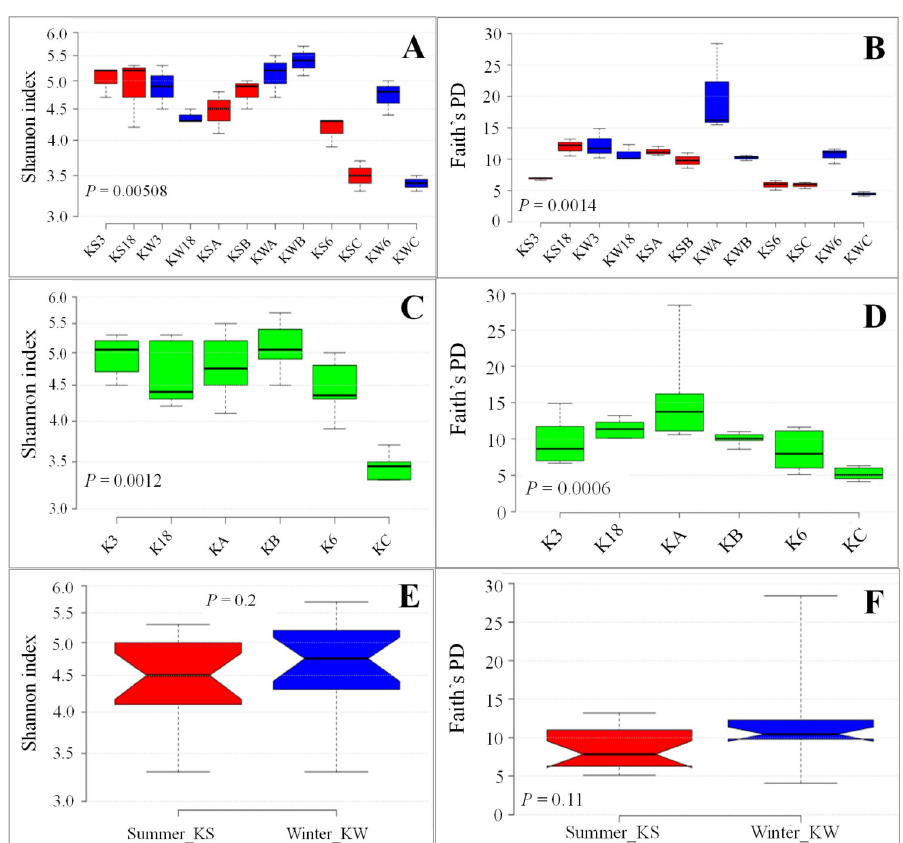
Fig 1. Alpha diversity indices across sample groups. A, C, and E: Shannon diversity indices across samples, stations, and seasons, respectively. B, D, and F: Faith’s phylogenetic diversity indices across samples, stations, and seasons,